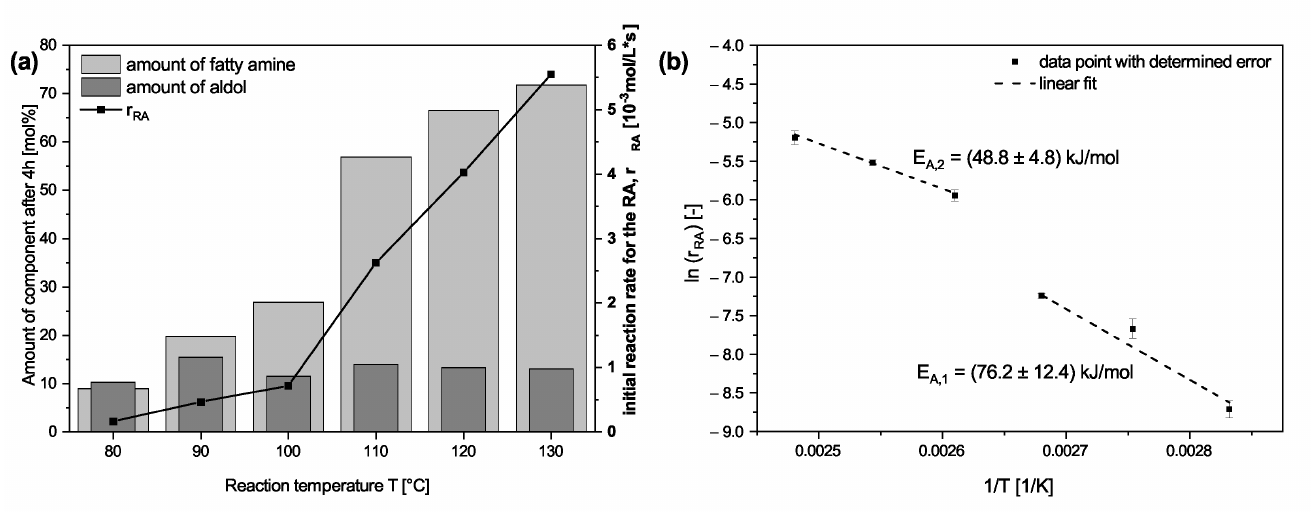
Figure 3. ( a ) Effect of the reaction temperature on the reductive amination of undecanal with diethylamine. ( b ) Arrhenius diagram with determined activation energies for the Rh-catalyzed reductive amination. Reaction conditions: p=30bar, 0.28mol% Rh, 1.12mol% SX, 17.6 mmol undecanal, 9g dodecane (co-solvent), 12g water, α =0.5, γ =0.08 Marlophen NP8, 1wt% Na 2 SO 4 , 1200rpm, t =4h.